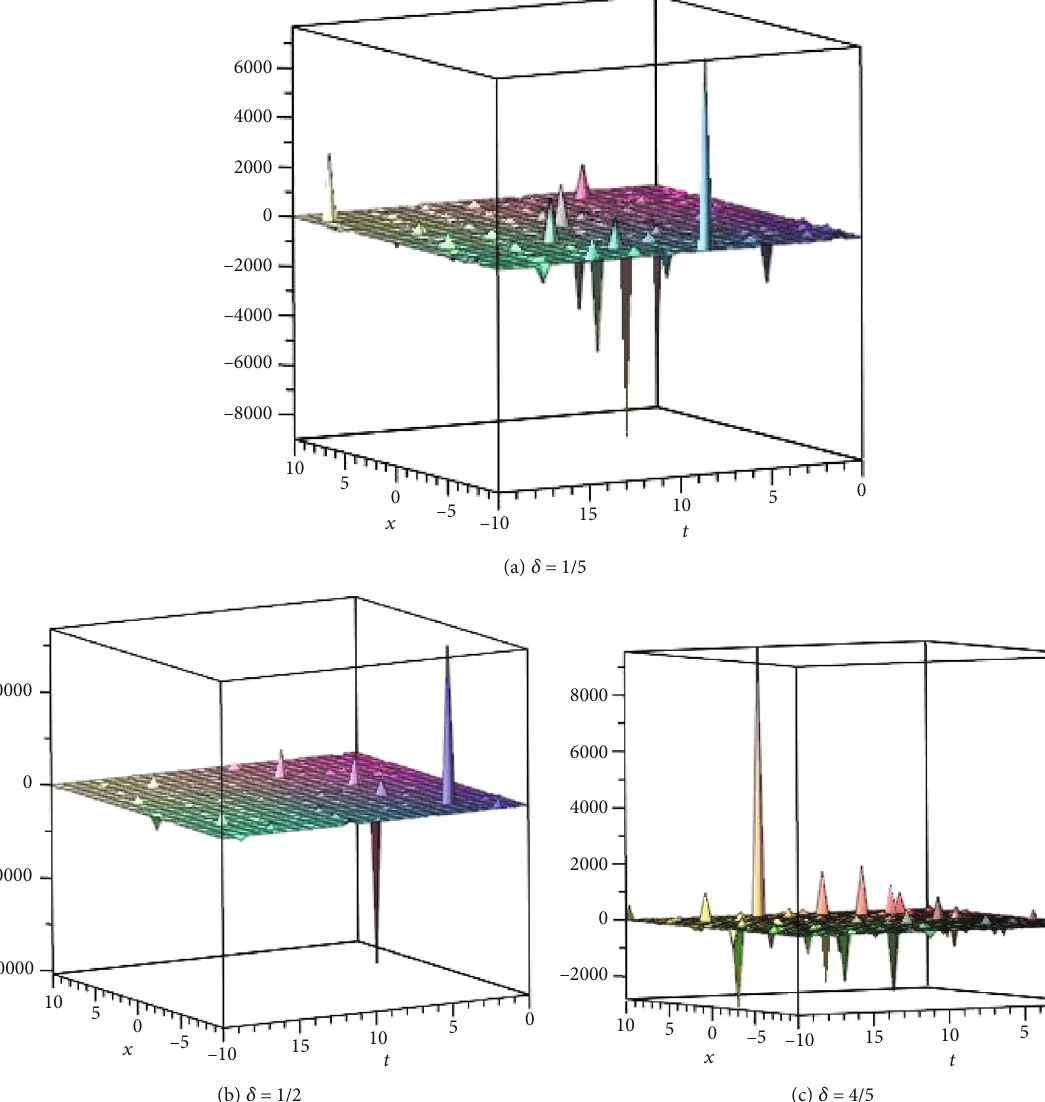
, x Þ in Equation (27) for di ff erential values of the fractional parameter δ Figure 3: The positive real part of u 3 1 ð t